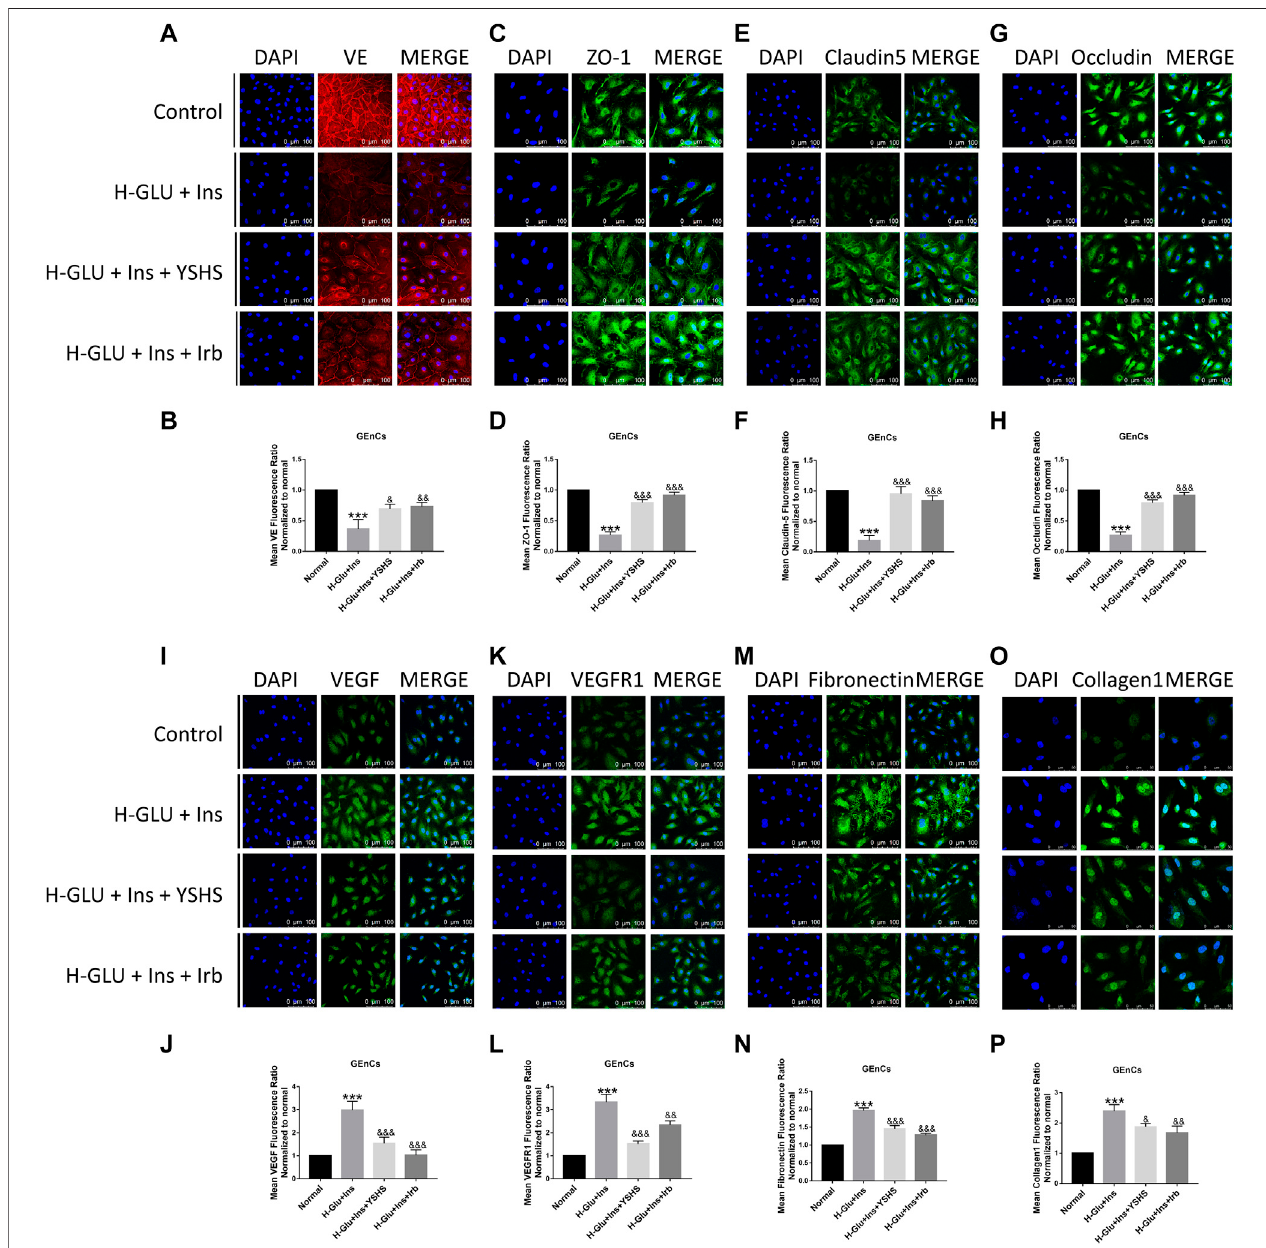
FIGURE9| EffectofYSHSontheglomerular fi ltrationbarrierinGEnCcells.Immono fl uorescenceassayforGEnCstightjunctionproteinVE (A) ,ZO-1 (C) ,claudin-5 (E) , and occludin (G) under a laser scanning confocal microscope; and relative fl uorescence intensity for them were determined (B,D,F,G) . YSHS decreased VEGF (I) , VEGFR1 (K) , fi bronectin (M) , and collagen1 (O) expressions, and relative fl uorescence intensity for them (J) , (L,N) , and (P) were determined. Values are presented as means ± SEM. *** p < 0.001, vs. control; & p < 0.05, && p < 0.01, &&& p < 0.001, vs. H-Glu + Ins.